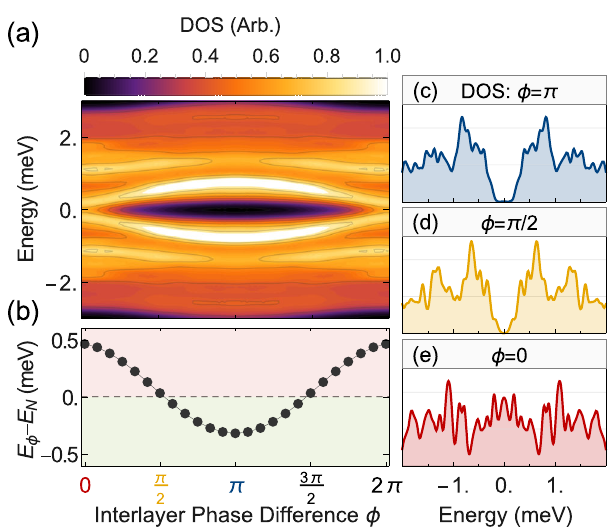
Fig. 4 Interlayer Josephson coupling. a Color intensity plot of the density of states (DOS) as a function of interlayer phase difference ϕ , tuned by shifting the phase of the order parameter in the bottom layer starting from the the self-consistent solution found at ϕ = π . Away from ϕ = π energy gap and coherence peaks are monotonically reduced with the gap closing around ϕ = 0, 2 π . b Superconducting condensation energy, i.e. energy of superconducting state relative to the normal state (N) as a function of interlayer phase ϕ . Pink region marks positive condensation energy, describing an unstable superconducting state. c – e DOS for interlayer phases ϕ = 0, π /2, π , respectively, taken as vertical cuts in a . Here, the coupling constant is J = 0.43 t and Fermi level at the upper van Hove singularity (conclusions are qualitatively unchanged for other J